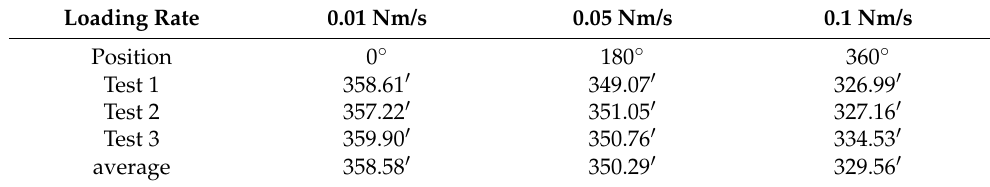
Table 12. Experiment results of δ e